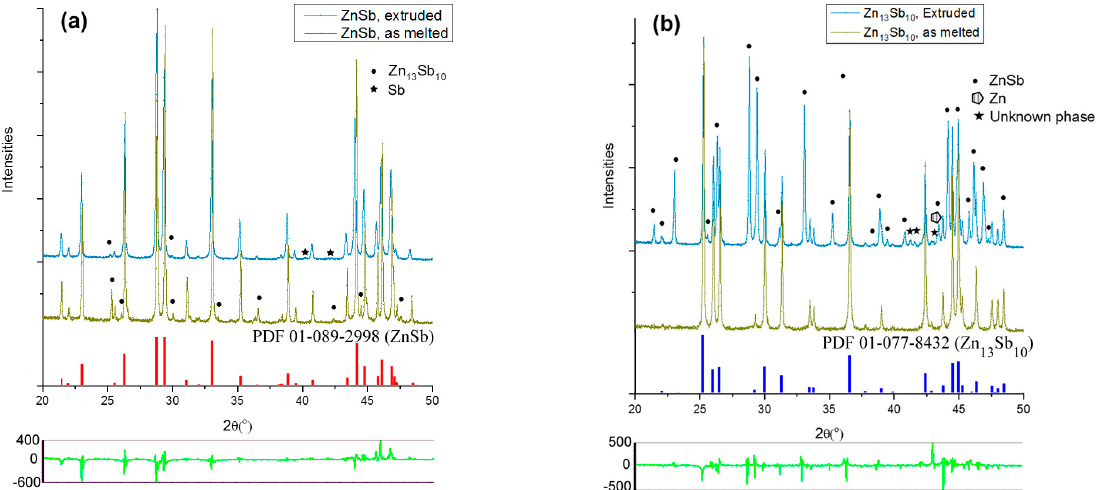
Figure 7. XRD patterns of SMed and extruded ( a ) ZnSb, and ( b ) Zn 13 Sb 10 samples. Unlabeled peaks correspond to the major phase of each sample. The patterns at the bottom of each panel show the difference between refined and measured patterns after fitting for extruded samples. Table 1. Phase percentage and unit cell volume of the phases extracted from the Rietveld refinement. The numbers in parentheses show the standard deviation of the reported values.